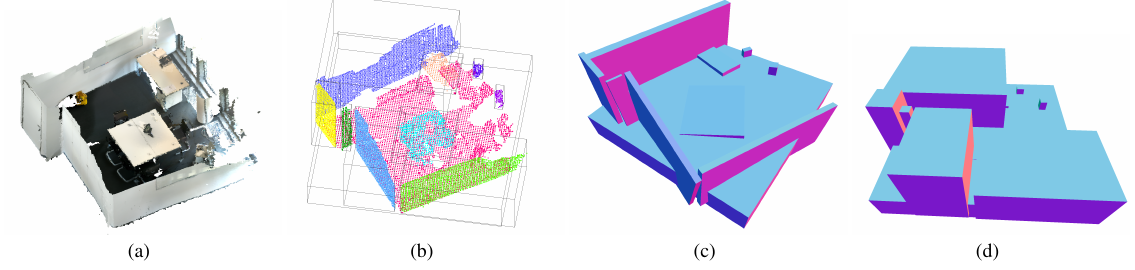
Figure 6. Examples of point cloud processing operations, including (a) The original point cloud, (b) Segmentation using region growing, (c) Generation of OOBBs, and (d) Generation of